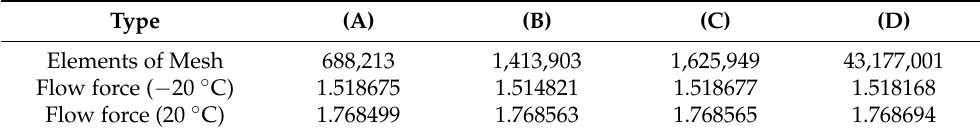
Table 1. Information on meshes of different temperatures.